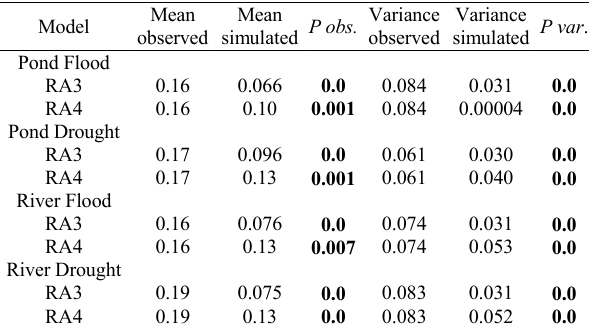
Table 2. Median and variance observed and simulated of the trophic niche overlap of the fish fauna in each spatial-temporal units, in Cuiabá River basin, Mato Grosso State, Brazil. Values in bold are patterns that were significantly different of the null model. Two different algorithms were used to test for non-random patterns: “scrambled-zeros” (RA3) and “conserved-zeros” (RA4). P obs . = probability that the observed niche overlap mean is higher than the observed one; P var = probability that the observed variance is higher than the simulated Mean Mean Variance Variance Model P obs. P var . observed simulated observed simulated Pond Flood RA3